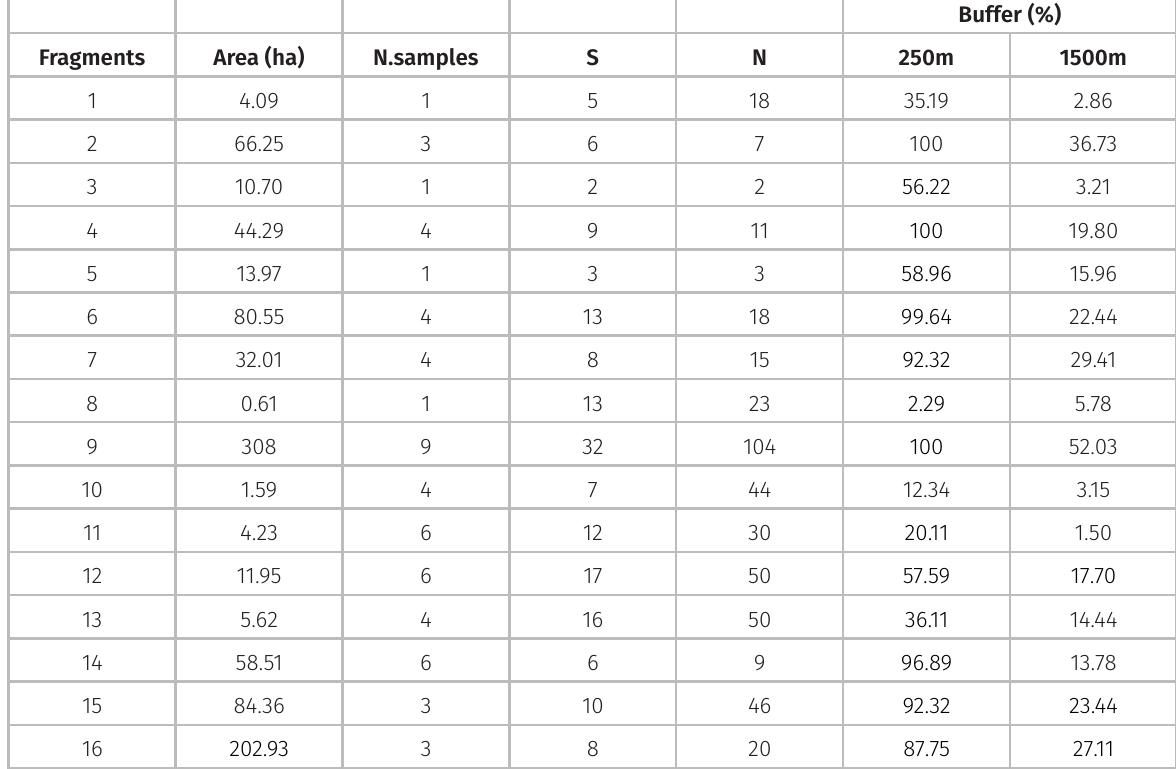
Table I. Forest fragments of Chrysomelidae (Coleoptera) sampling in Dourados, Mato Grosso do Sul State, Brazil, with Malaise traps. S = species richness; N = abundance; Buffer (%) = percentage of forest cover in buffers of 250m and 1500m radius from the centroid of each